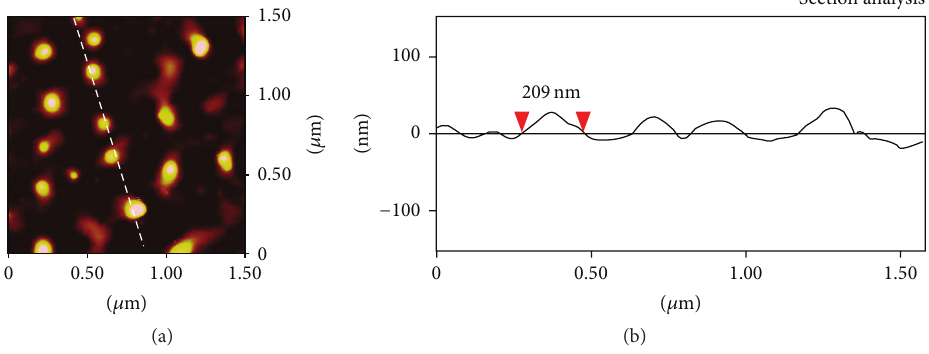
Figure 3: Atomic force microscope images of SrAl 2 O 4 :Eu 2+ (a) and respective cross section analysis